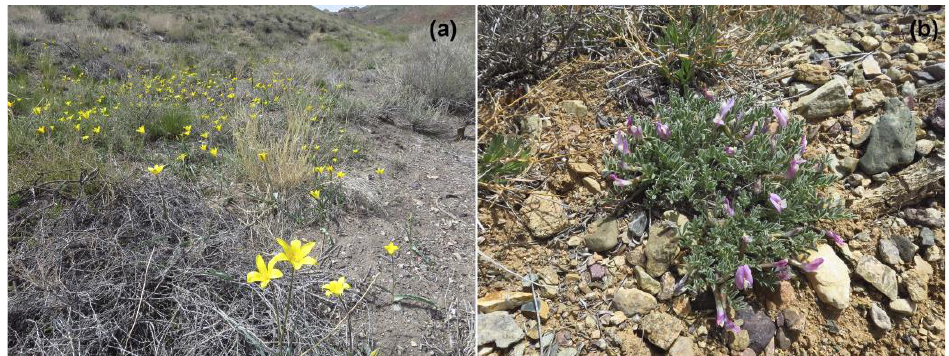
Figure 7. Habitat ( a ) and larval foodplant ( Astragalus lasiophillus ) ( b ) of P. panope in Dzhungarian Alatau, E. Kazakhstan. Photo: V.Lukhtanov.